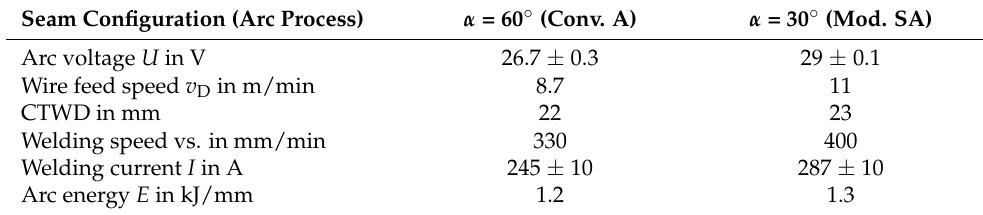
Table 3. Welding parameters for TEKKEN